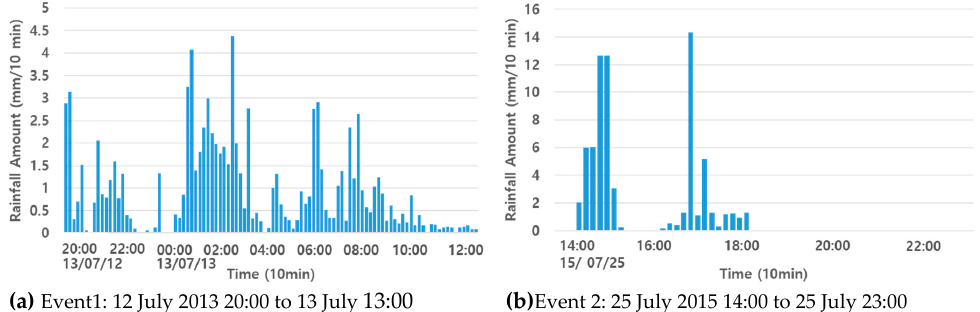
Figure 3. Accumulated rainfall amount (mm/10 min) during ( a ) Event 1 and ( b ) Event 2, observed at